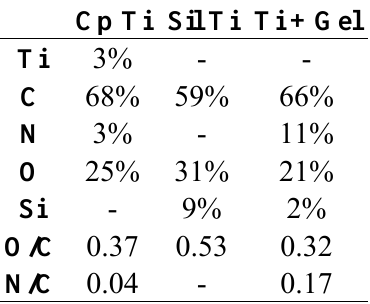
Table 4. Atomic surface composition of commercially pure Ti (cp Ti), TMSPMA silanized Ti and gelatin-coated Ti acquired by means of XPS.